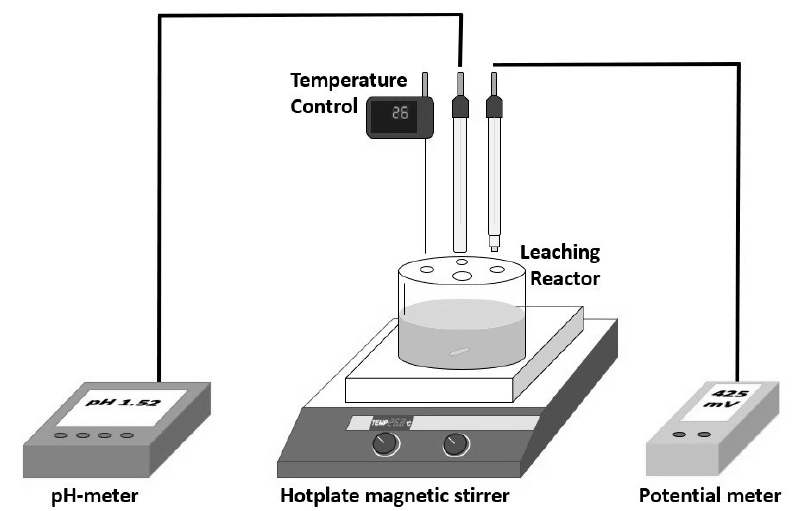
Figure 2. Scheme of the magnetic stirrer leaching system.